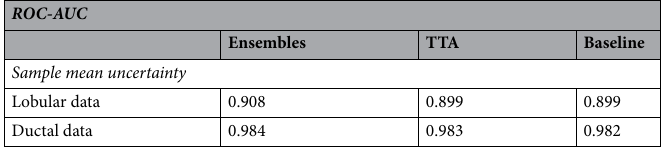
Table 6. Tumour metastases detection on Lobular and Ductal data: ROC AUCs of combination of sample means uncertainty and the softmax